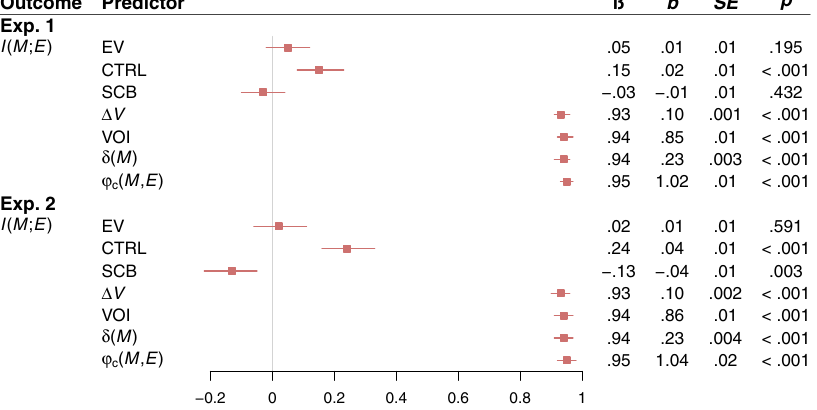
ð M ; E Þ ). Statistics are derived from LMMs c